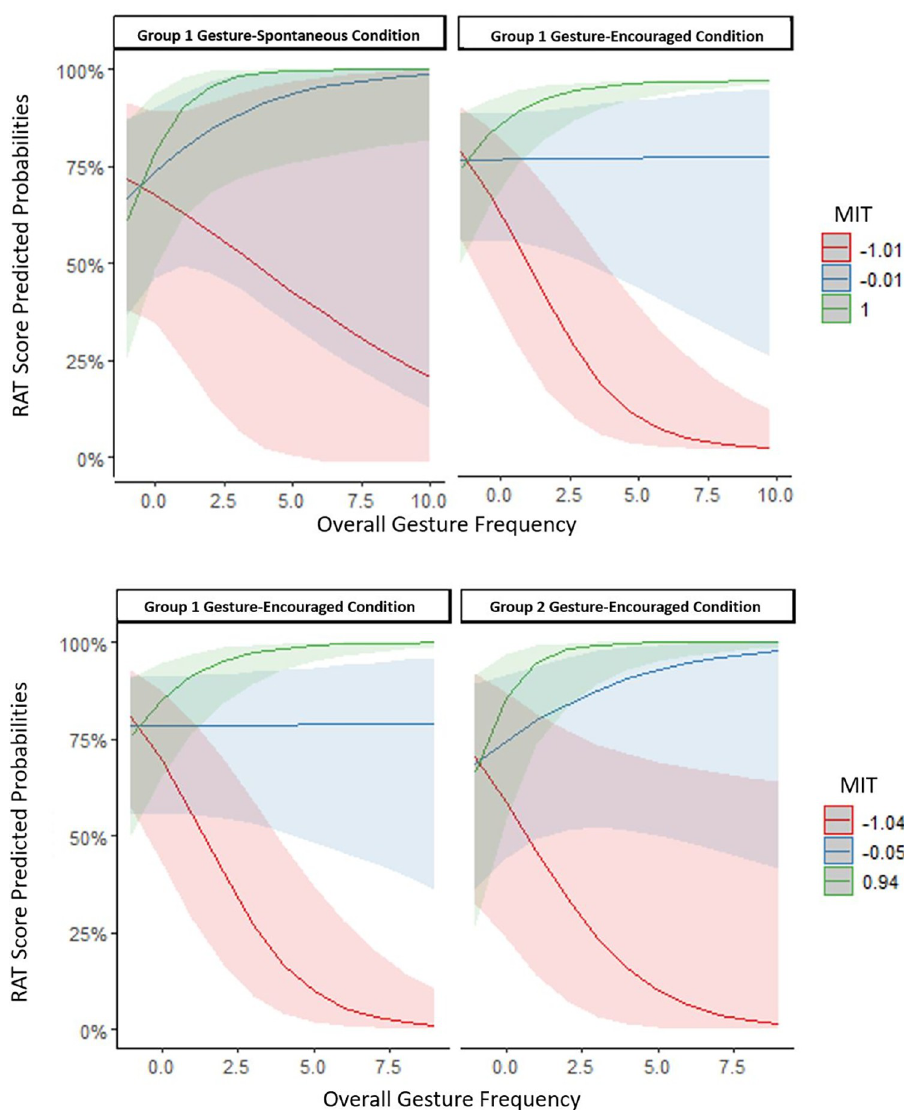
Fig 1. The relationship between predicted probabilities of RAT scores and scaled overall gesture frequency as a factor of scaled MIT scores (mean, below and above the mean) for the gesture-spontaneous and the gesture- encouraged condition of Group 1 and the gesture-encouraged condition of Group 2. A: within-subject effects; B: between-subject effects.